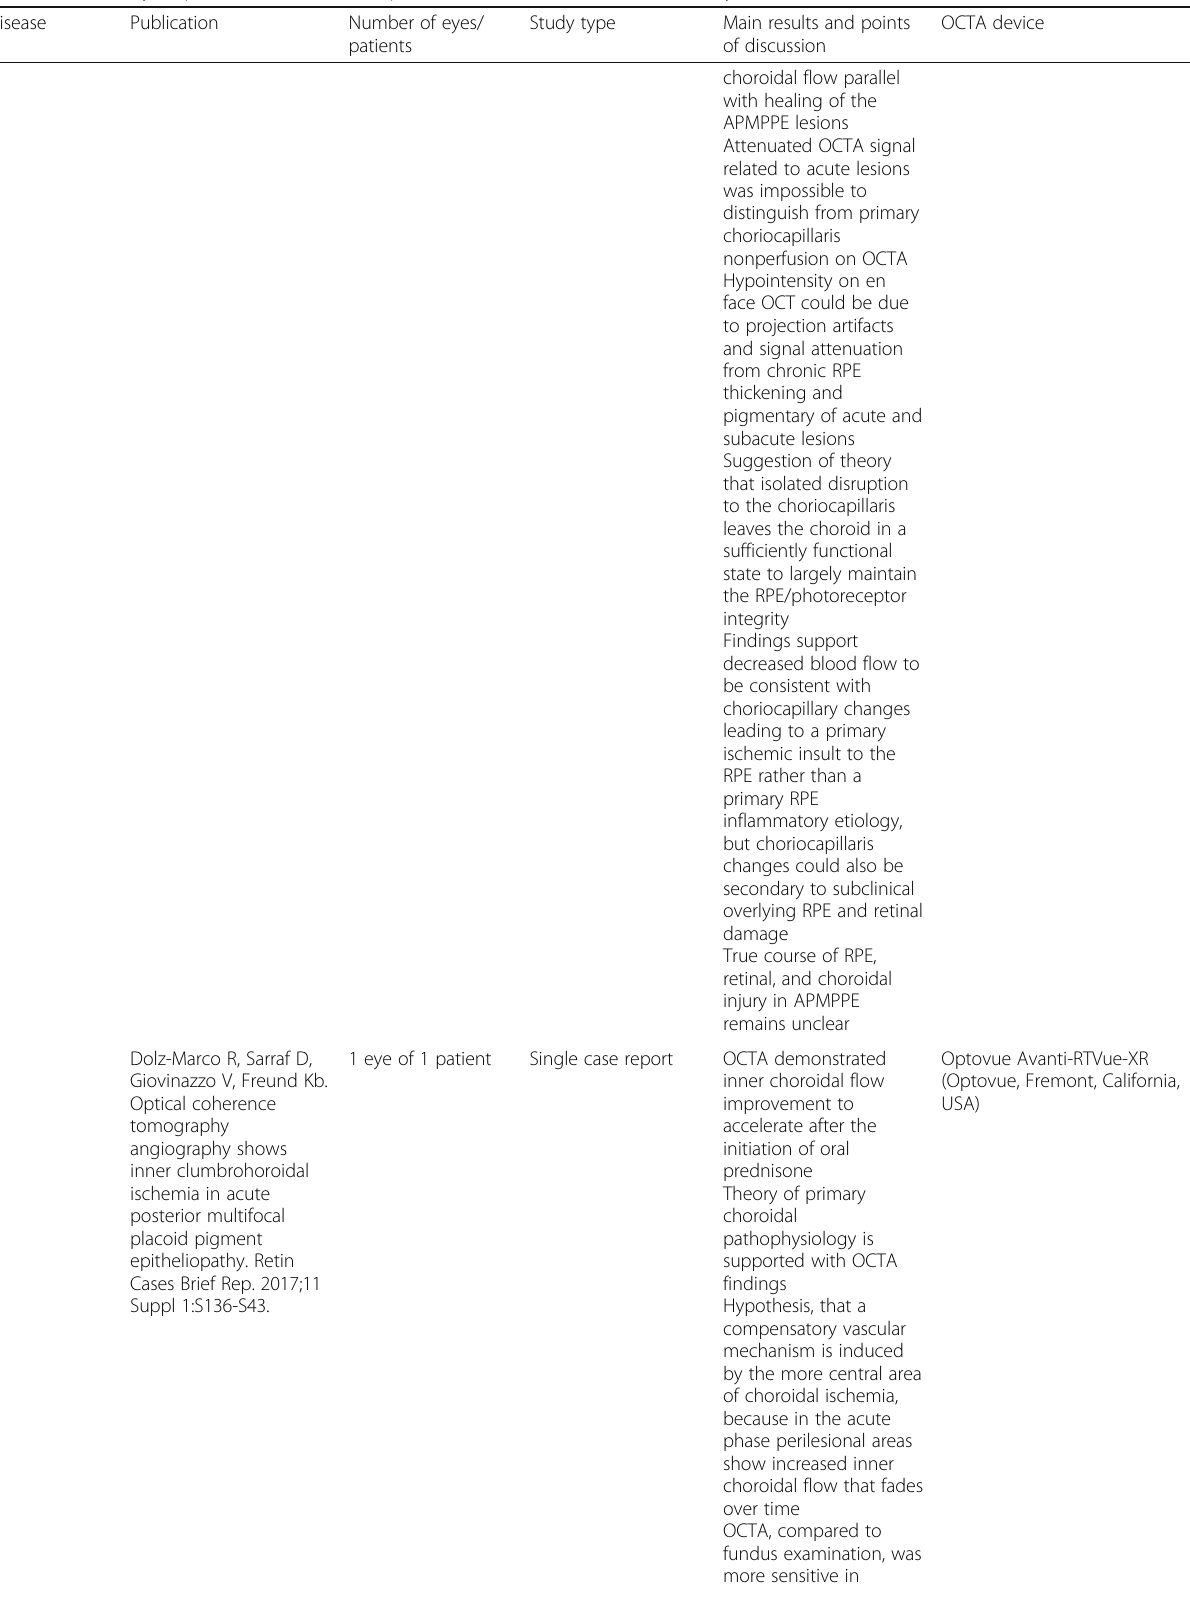
Table 1 Summary of publications on the implementation of OCTA in white dot syndromes (Continued)